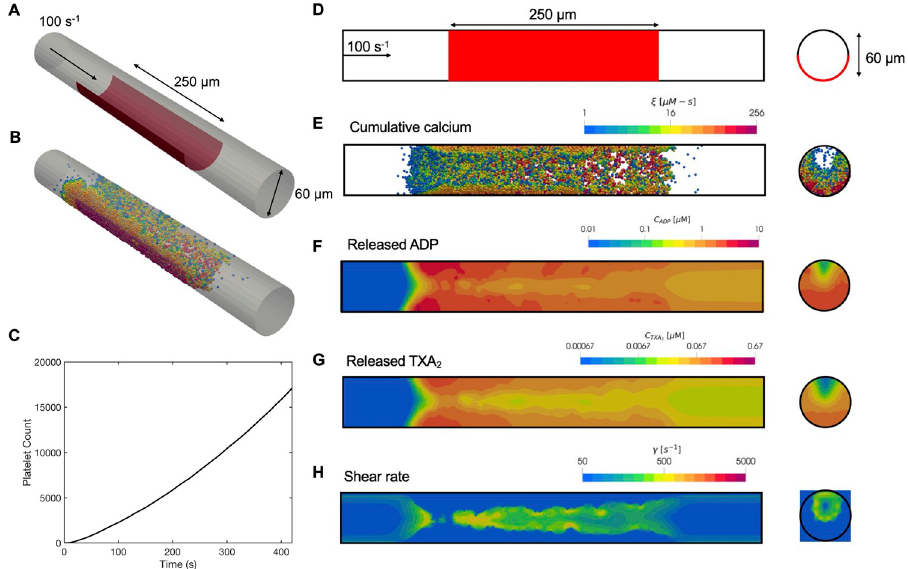
Fig 6. Simulation results of platelet aggregation under flow in a cylindrical tube. Schematic of the cylindrical tube geometry: (A) oblique view and (D) side view. Inlet flow: 100s -1 ; reactive surface containing collagen and TF: red bar. (B,E) Platelet activation (blue indicates inactivated and red, fully activated) and deposition after 400 seconds. (C) Dynamics of platelet aggregate count observed over time. Released (F) ADP and (G) TXA 2 , and (H) the local shear rate contours plotted along the center of the tube after 400